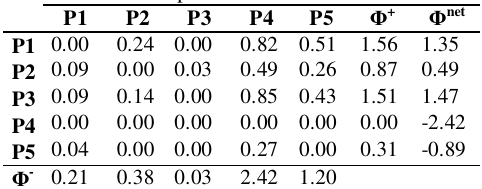
Table 8. Positive, negative and net flows for the alternative